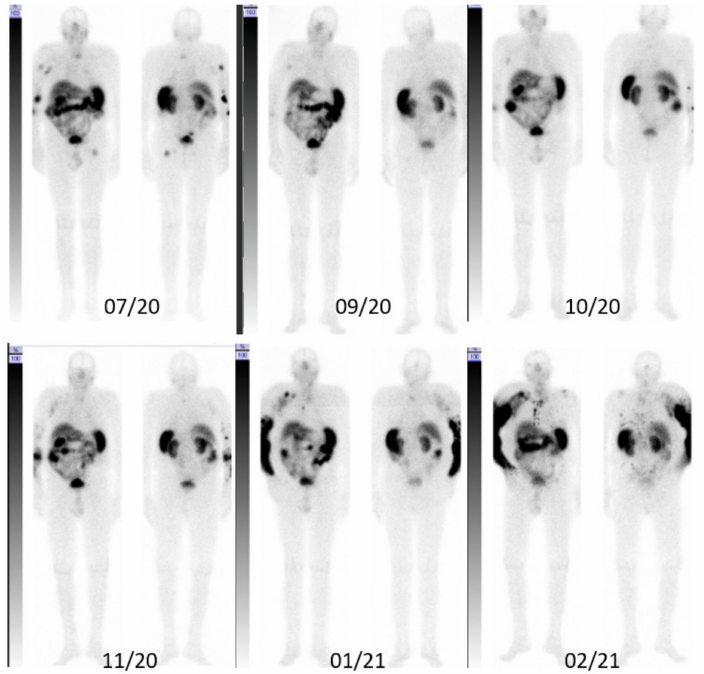
Figure 3. Anterior ( left ) and posterior ( right ) post-therapy scintigraphy images of patient A. Patient B . An 85-year-old female with a history of B-CLL since 2009. The patient was diagnosed with MCC of her left nostril (pT1 cN0 cM0) in 2014. In 01/2020, she progressed with rapidly growing distant skin/soft-tissue metastases of the right